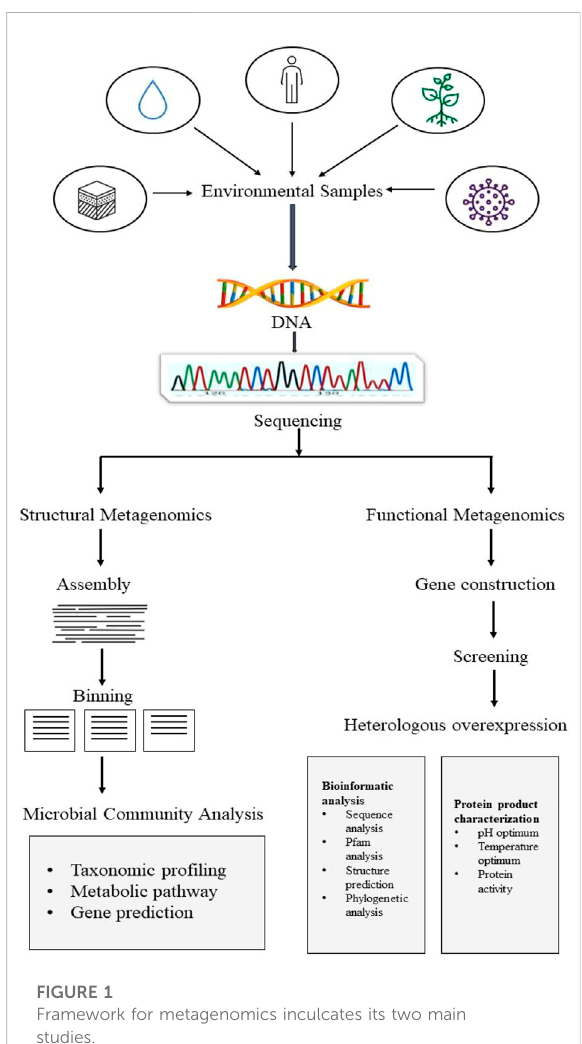
FIGURE 1 Framework for metagenomics inculcates its two main